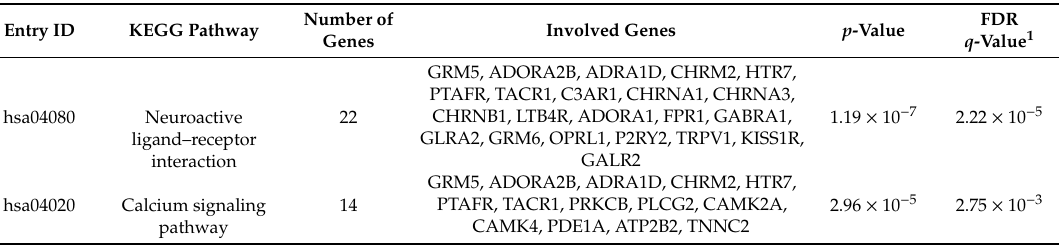
Figure 5. Kyoto Encyclopedia of Genes and Genomes (KEGG) pathways significantly enriched between TC and MTA. ( a ) Venn diagram analysis of the DEGs in TC compared to MTA. ( b ) KEGG pathways significantly enriched in TC for 24 h. ( c ) KEGG pathways significantly enriched in TC between 24 h and 72 h. ( d ) KEGG pathways significantly enriched in TC for 72 h. The identified KEGG pathways are presented according to gene expression regulation. Table 1. Identified KEGG pathways involved in TC.